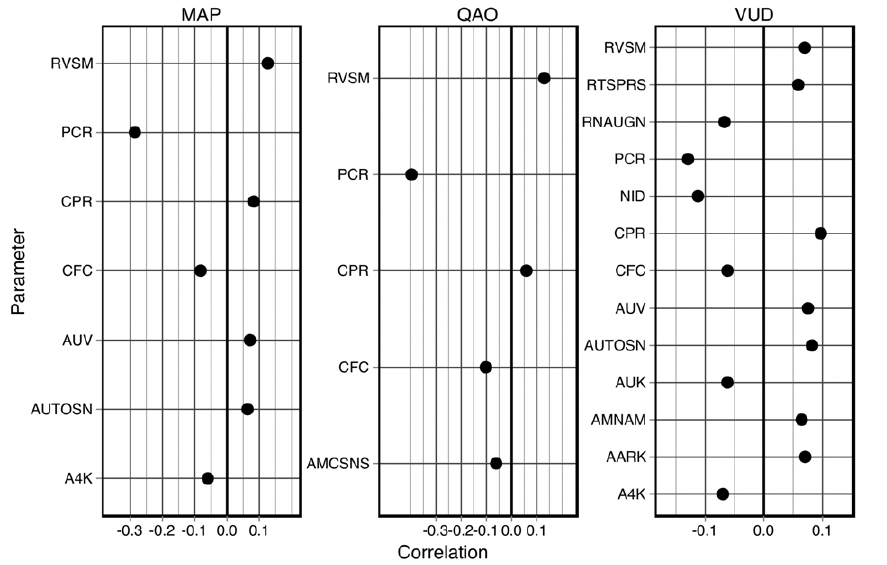
Figure 4. Significant correlations between model parameters and the elementary effects of HYL at t ~ 1 hour . Correlations ( p v 0 : 01 ) are shown for the elementary effect of HYL on mean arterial pressure (MAP), cardiac output (QAO) and rate of urine production (VUD).